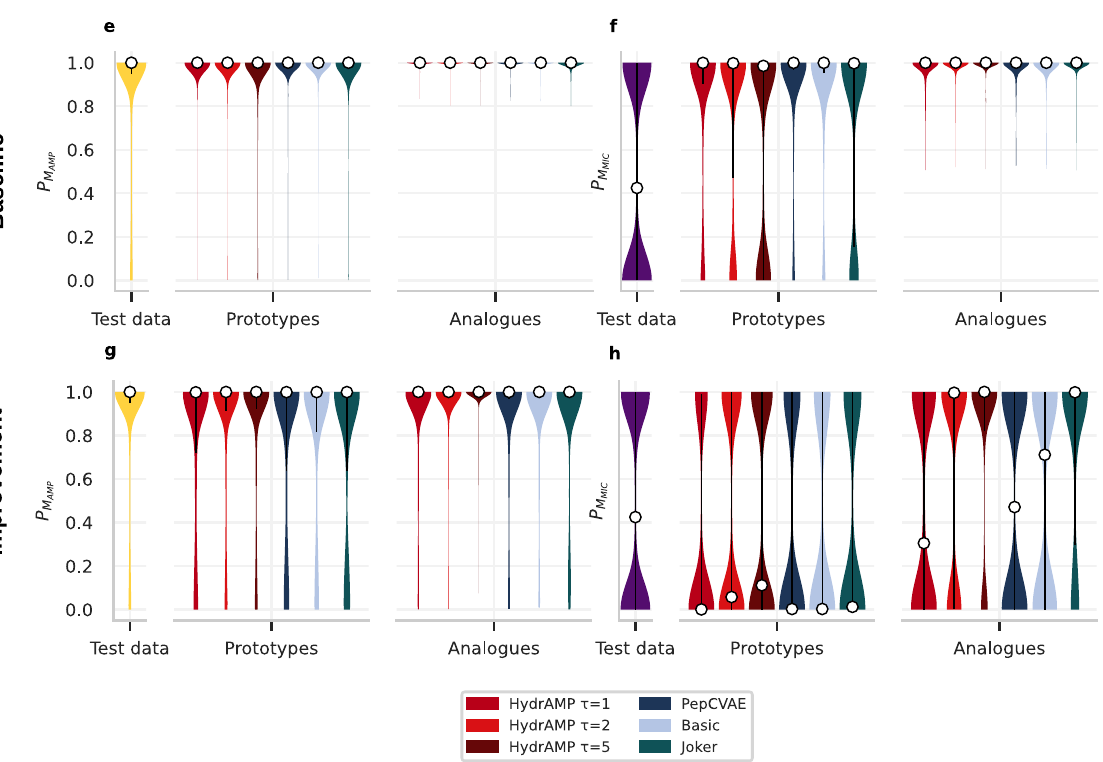
Fig. 3 | Analogue generation performance in terms of P M and P M for ( a, b ) or improvement ( c, d ) discovery criteria. e, f, g, h The probability distribu- AMP MIC HydrAMP(red),in comparisonto PepCVAE (dark blue), Basic (light blue), and ( e, g ) and P M ( f, h ) for n =1319 positive prototypes and the tions of P M AMP MIC Joker (dark green) comparedto thedistributionoftest data (yellowfor P M generated analogues that met the baseline ( e, f ) or improvement ( g, h ) discovery AMP and violet for P M ). Test data contains all the prototypes and serves as a refer- criteria. The white dots mark the median of each distribution. The black vertical MIC ( a, c ) and P M ( b, d ) for ence. a, b, c, d The probability distributions of P M linesdenote the interquartile range ofeach distribution. Source data areprovided AMP MIC as a Source Data fi n =1253 negative prototypes and the generated analogues that met the baseline